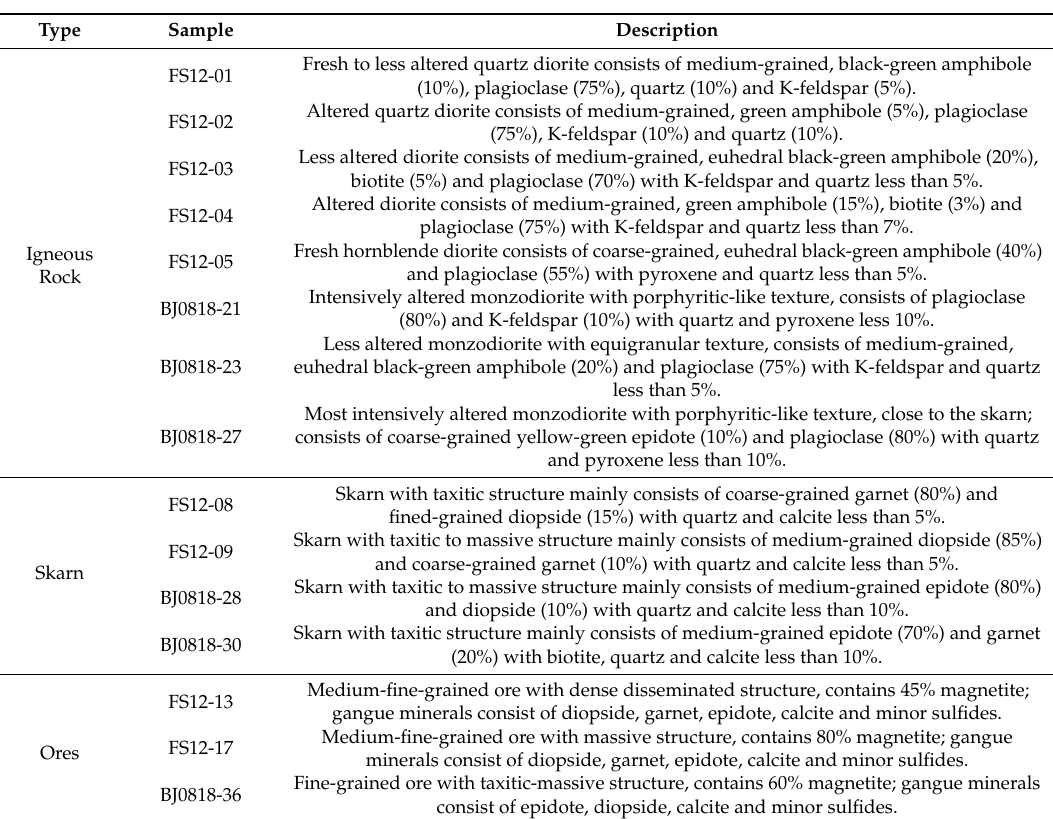
Table 1. Sample description of typical hand specimens of altered diorites, skarn and ores from the Han-Xing iron